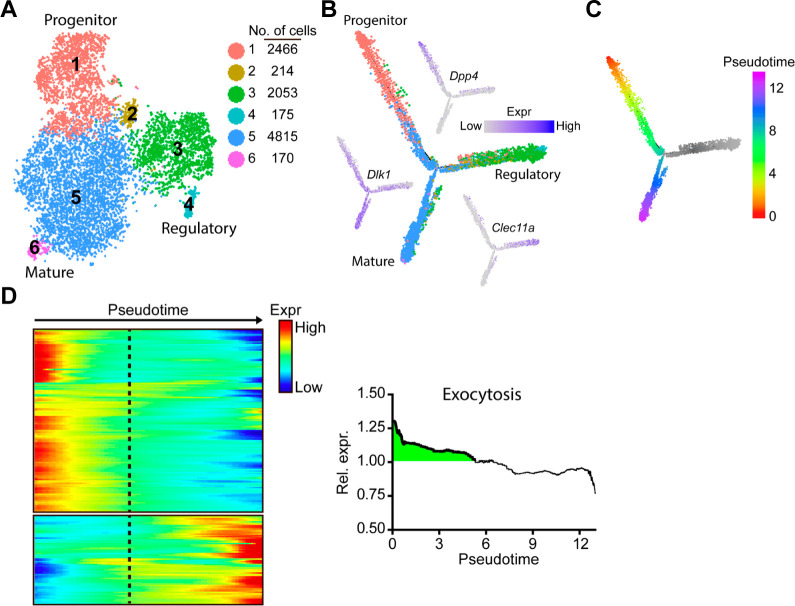
Single-cell RNA sequencing and cell trajectory analysis delineate exocytosis of adipocyte progenitors in mouse subcutaneous white adipose tissue (WAT).Re-analysis performed using publicly available data (GEO dataset # GSM3717977) (Merrick et al., 2019). (A) Unsupervised clustering of cells from the subcutaneous WAT confirmed six distinct cell groups represented on a tSNE map. (B) Trajectory analyses, color coded based on clustering from panel ‘A’. In similarity to original report (Merrick et al., 2019), Dpp4+ progenitor cells, Clec11a+ regulatory cells, and Dlk1+ pre-adipocytes. Branch identities were confirmed using marker gene expression. (C) Pseudotemporal cell ordering of adipocytes along differentiation trajectories. Clec11a+ regulatory cells (gray) were not included for downstream analyses. (D) Pseudotemporal expression heatmap of genes previously linked to activating/promoting exocytosis. Dotted line denotes branch point between mature and regulatory adipocyte populations. (E) Combined, normalized expression of pro-exocytosis genes shows enrichment (>1) in early progenitors (green shaded area), while more differentiated cells show below average expression.